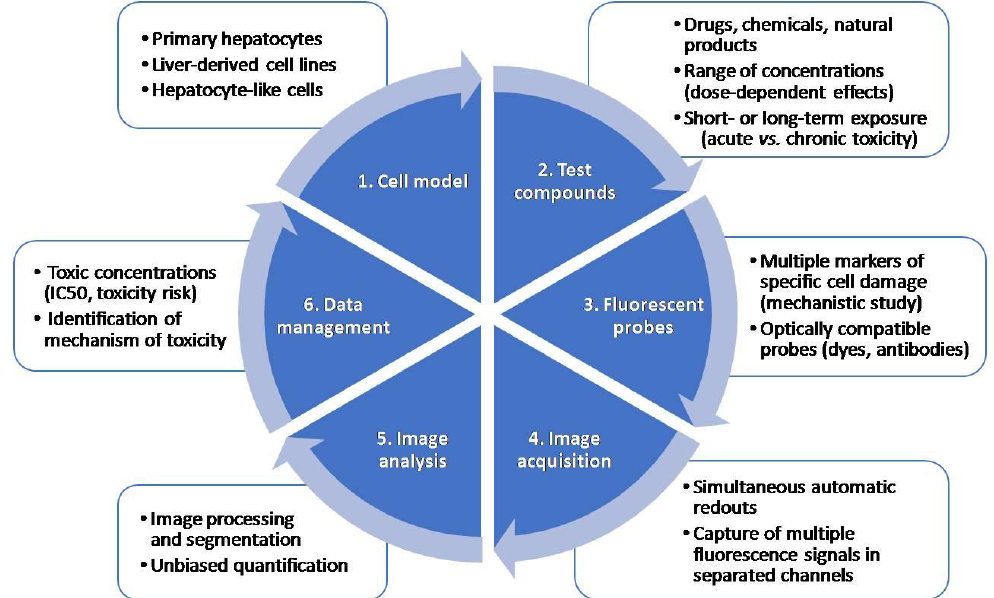
Figure 2. Major steps in a high-content screening (HCS) assay. An HCS assay includes the selection of an appropriate test system, incubation with test compounds at a range of concentrations, incubation with a combination of fluorescent probes, automated image acquisition, analysis and data management.